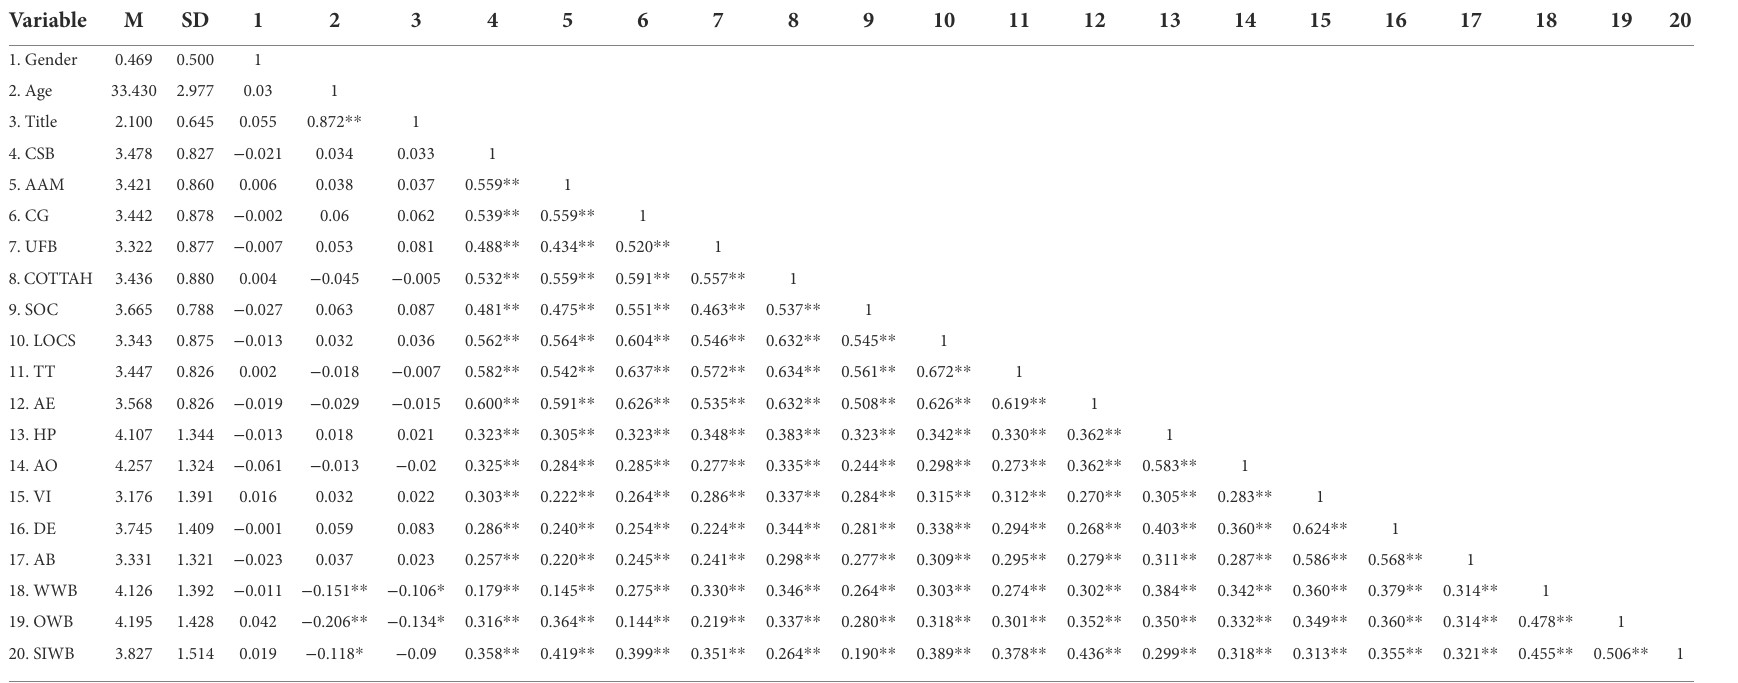
TABLE 2 Means, standard deviations, and correlations of the major study